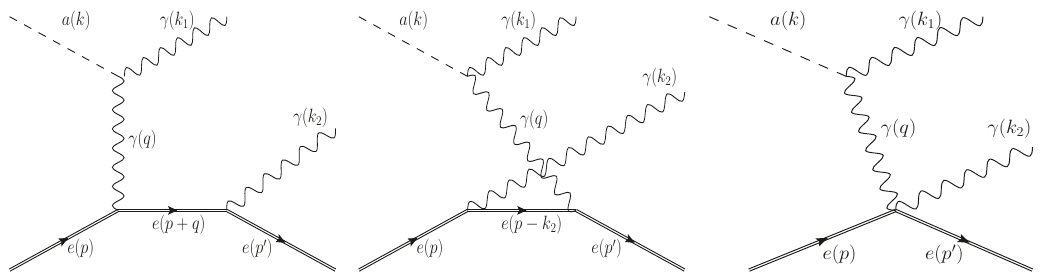
Figure 2 . Leading order Feynman diagrams contributing to radiative axion-photon conversion on electrons (4.1) through the inverse Primakoff mechanism. The diagrams with interchanged photon 4-momenta k 1 and k 2 should be